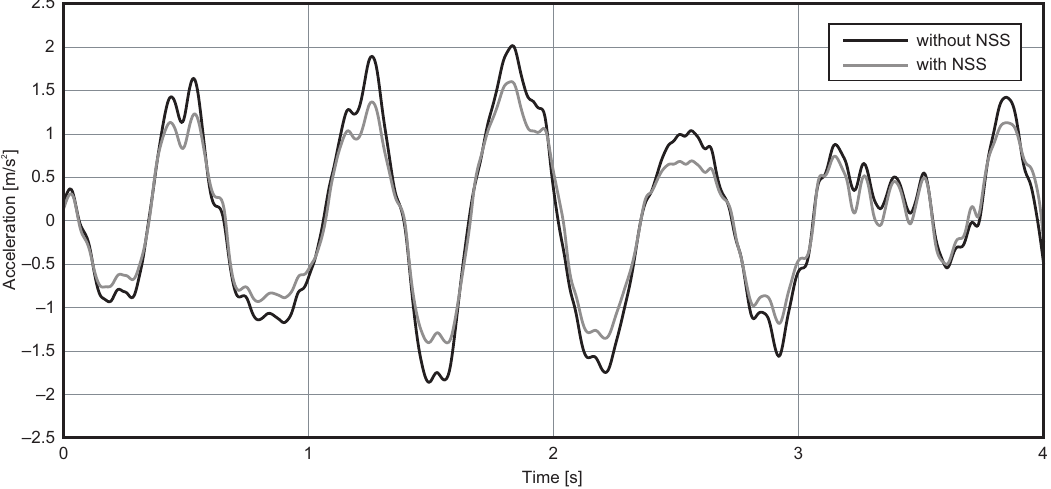
Figure 9. Close-up view of the weighted acceleration versus time for the Type D road profile and a mass of 60 kg. Table 2. Root mean squared weighted acceleration values for different road profiles and vehicle